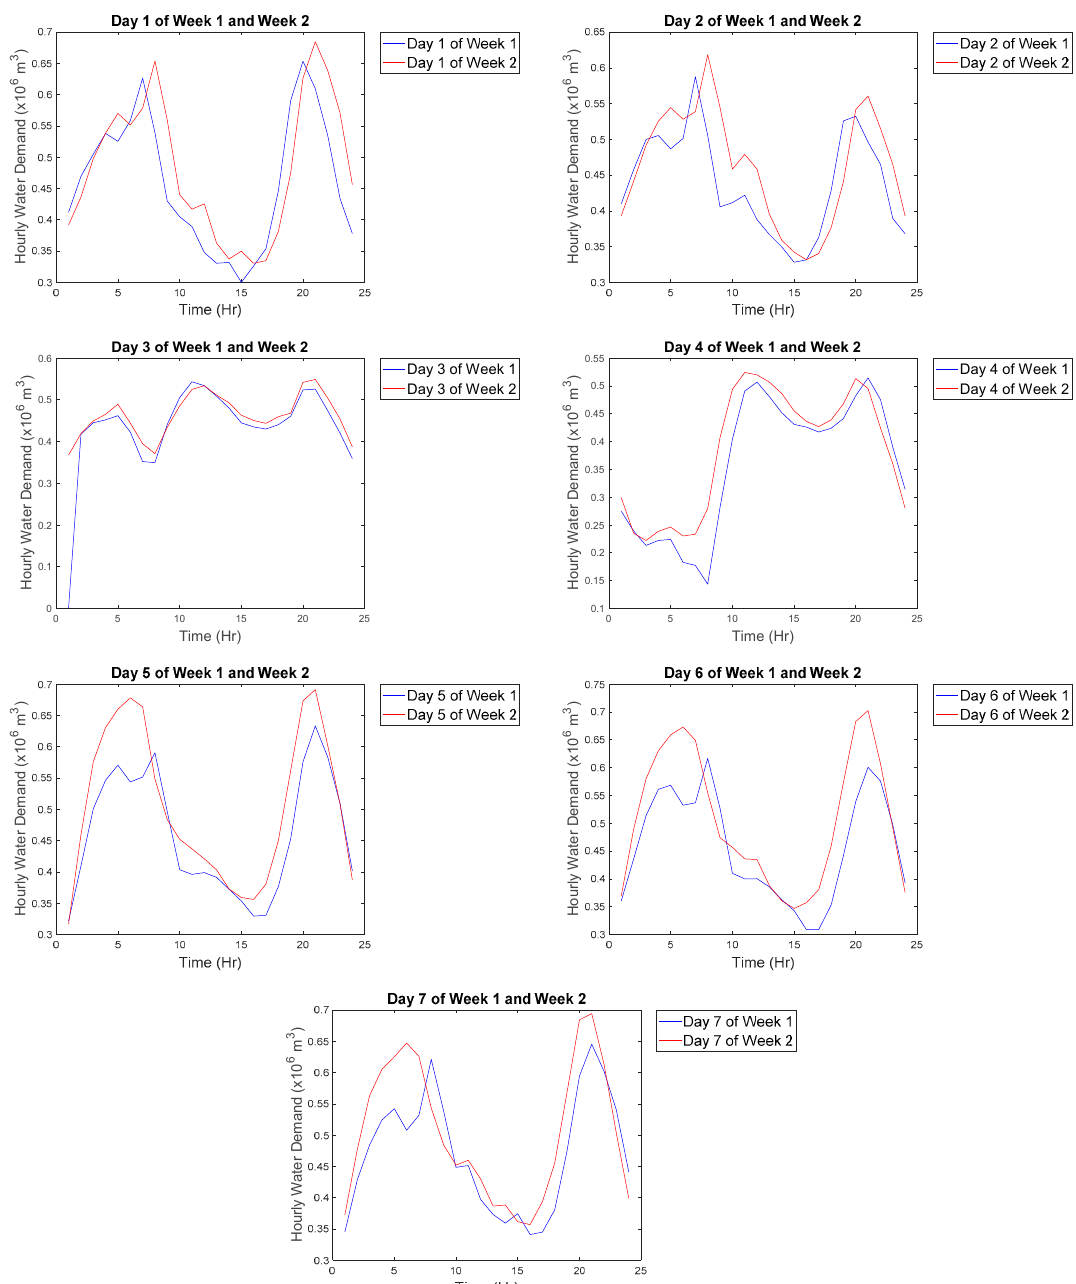
Figure 1. Week 1 and Week 2 of data.